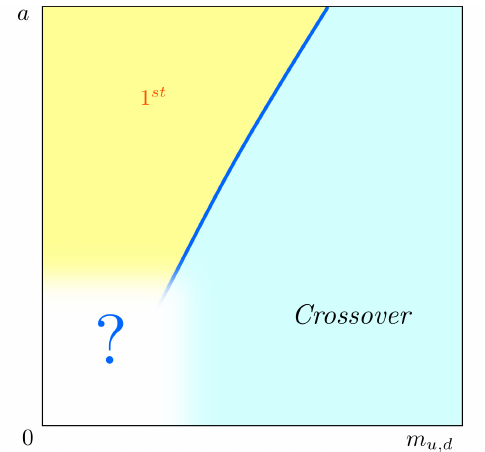
Figure 2. A Columbia-like plot for the ( a , m u,d )-plane. The chiral phase transition for any fixed value of m s weakens as the lattice spacing is decreased.